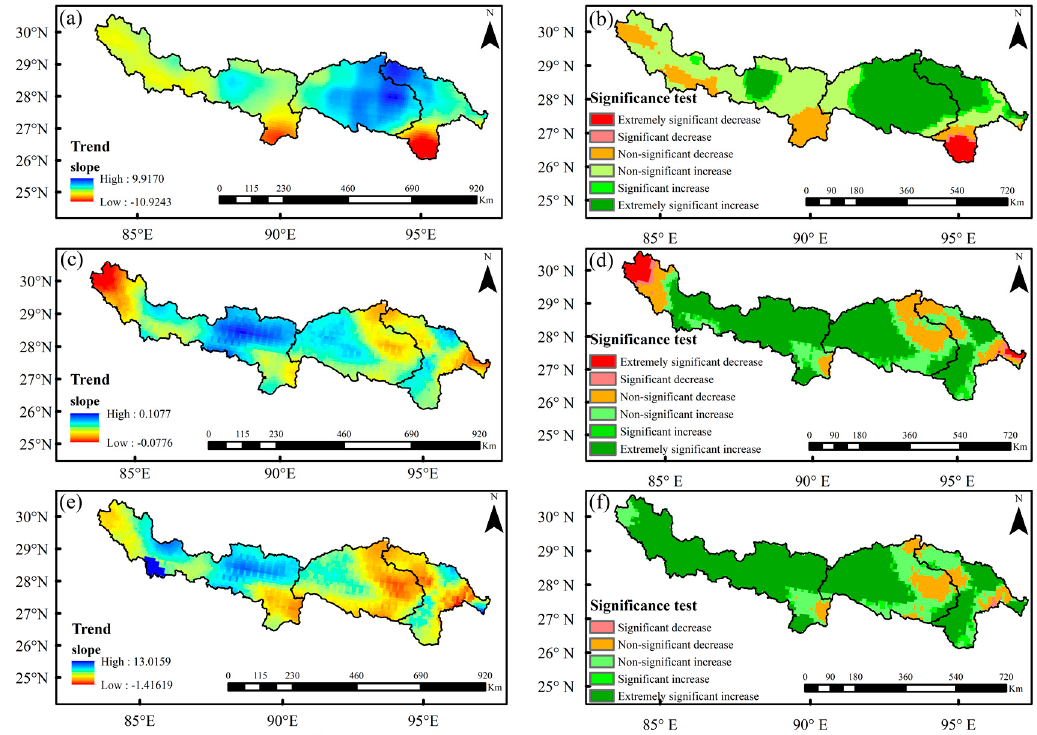
Figure 16. Analysis on the spatial variation trends of the annual precipitation ( a, b ), temperature ( c, d ), and PET ( e, f ) with the significance test.